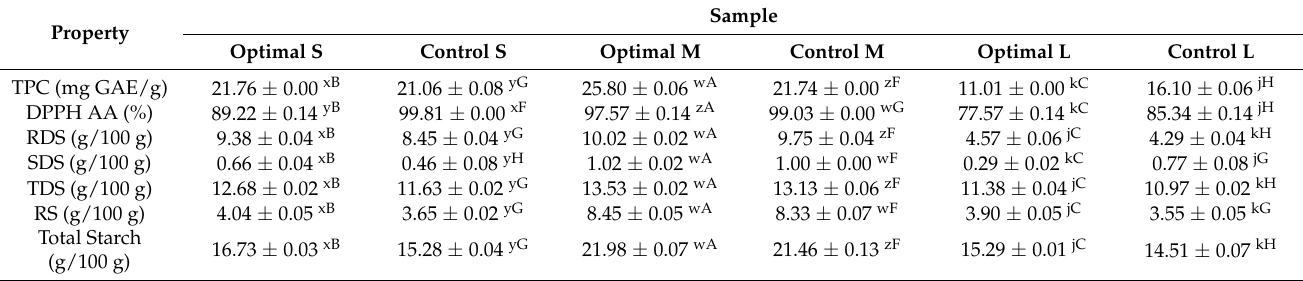
Table 6. Total polyphenols, antiradical activity, and starch digestibility of optimal and control samples.